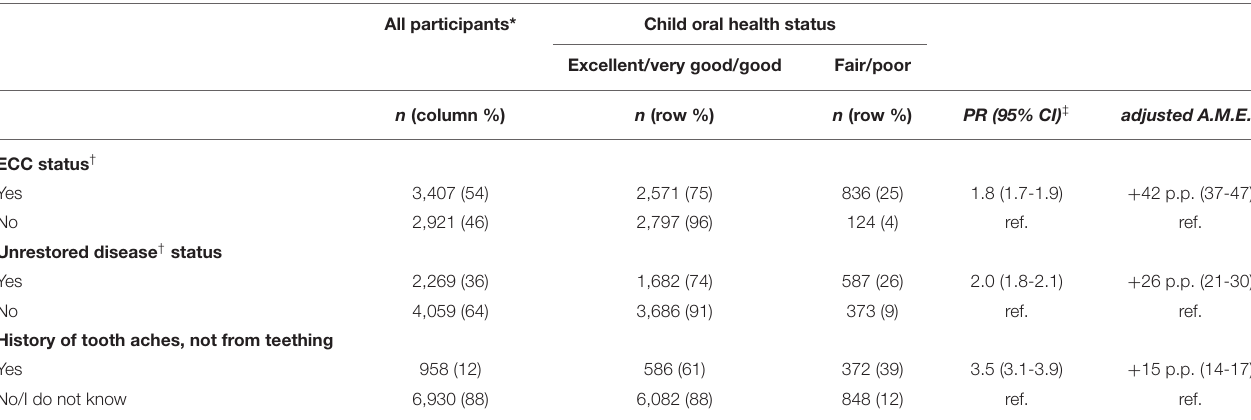
TABLE 3 | Clinical and guardian-reported measures of child oral health in the ZOE 2.0 study sample, and associations with reported child oral health